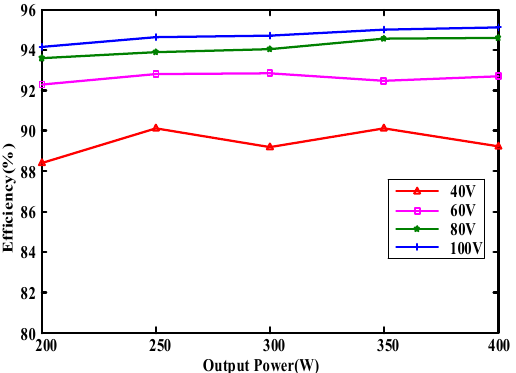
Figure 11. E ffi ciencies of the proposed converter with di ff erent output powers at di ff erent input Figure 11. Efficiencies of the proposed converter with different output powers at different input voltages (i.e., di ff erent voltage gains) when U out = 400 voltages (i.e., different voltage gains) when U out = 400 V.